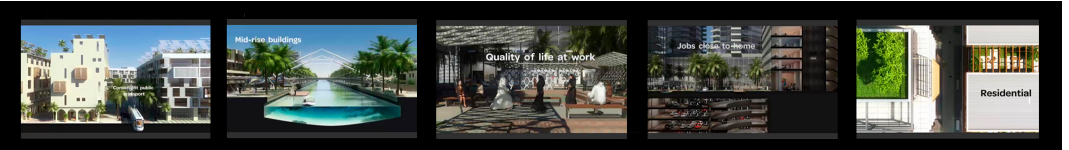
Figure 7. Plan Abu Dhabi 2030. Movie by Squint/Opera (London, UK), (5:29),